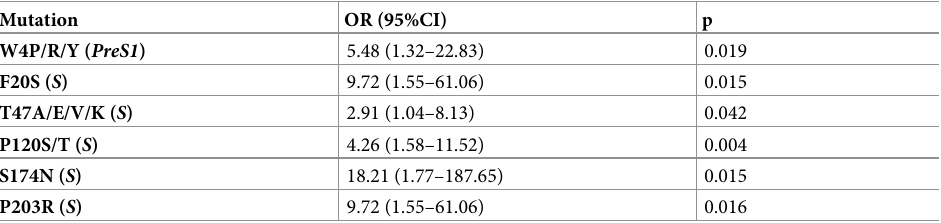
Table 5. Point-mutations related to HCC–multivariable analysis (n =